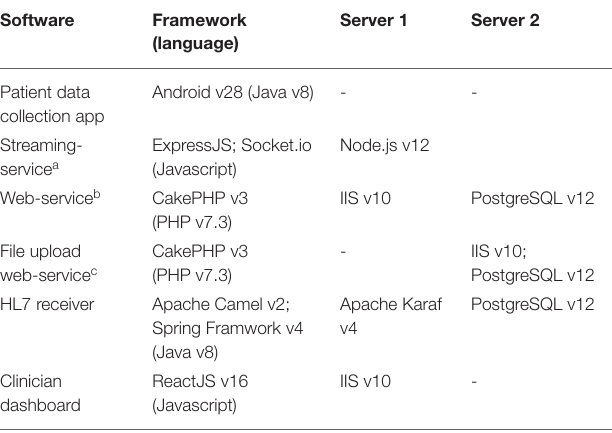
TABLE 2 | Technical specification of the system deployed in the isolation